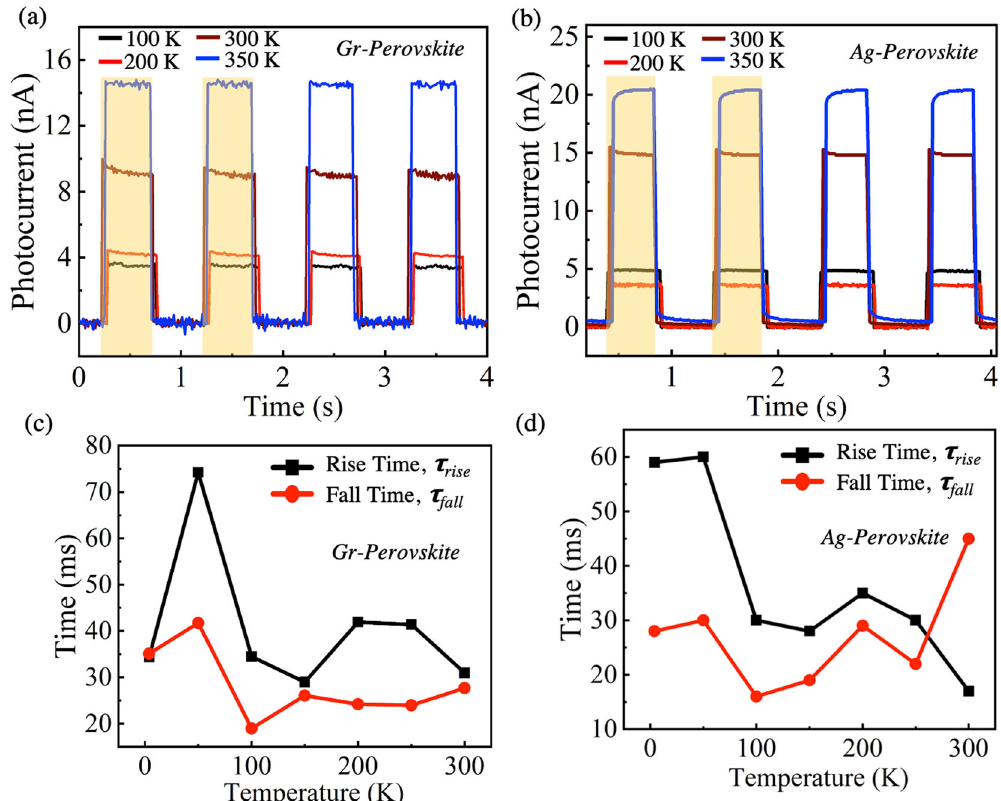
Fig. 5 Temperature-dependent temporal response. Temporal response of I p to periodic broadband light pulses, represented by shaded regions as examples for the fi rst two switching cycles, where I p is plotted for T ~ 100, 200, 300, and 350 K at F ~ 10.75 mW/cm 2 for a Gr- perovskite and b Ag-perovskite PDs. The τ rise and τ fall as a function of T , where the τ rise ~ 31 ms and τ fall ~ 27 ms were measured for c Gr- perovskite PD, while for d Ag-perovskite PD, the τ rise ~ 17 ms and τ fall ~ 45 ms at 300 K. At T ~ 4 K, the τ rise and τ fall values were found to be ~59 and 28 ms, respectively, for Ag-perovskite